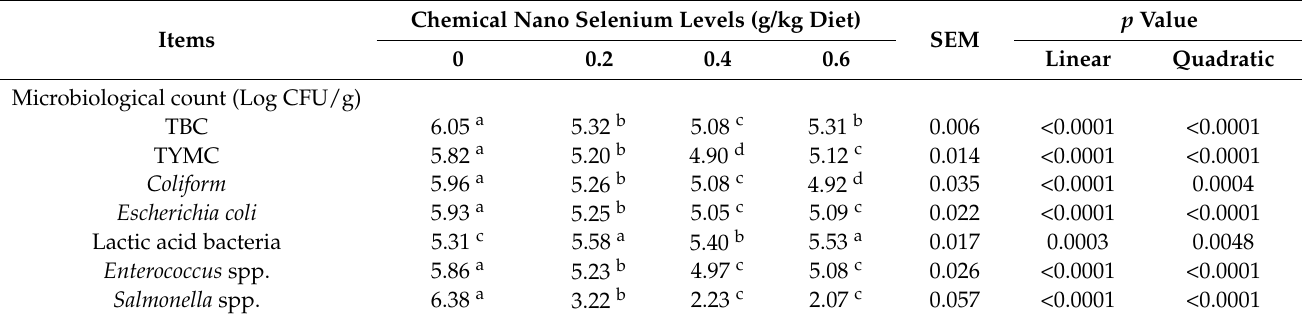
Table 9. Caecal microbiota of growing Japanese quail as affected by dietary